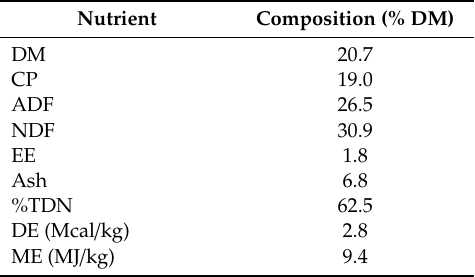
Table 1. Nutrient and phenolic antioxidant compositions of ryegrass pastures grazed by Tattykeel Australian White lambs 1